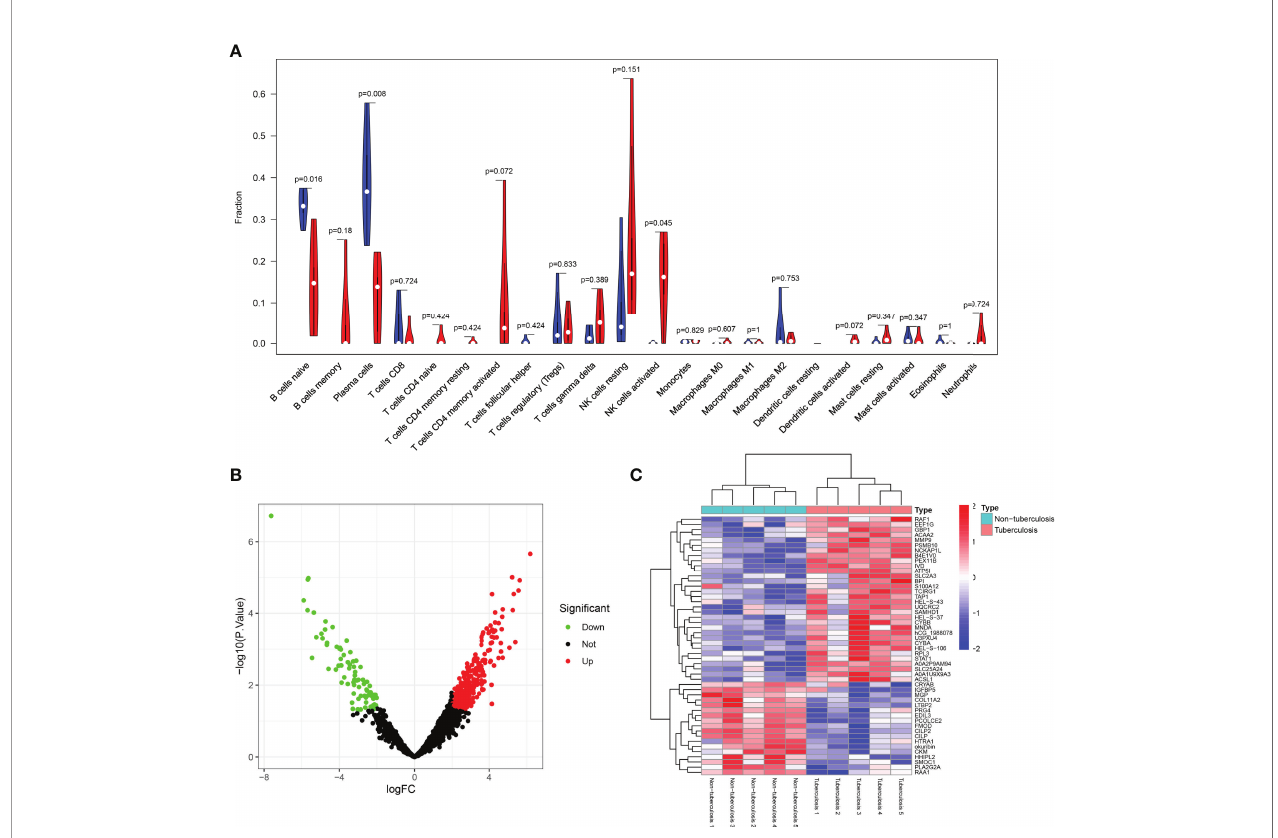
FIGURE 6 | Violin, volcano, and heatmap were plotted. (A) The comparison of 22 immune cell scores in spinal tuberculosis and non-spinal tuberculosis was plotted by the violin plot. There were statistical differences among the three types of immune cells, including B cells naive, platelet cells, and NK cells activated. (B) The volcano plot showed that the differential proteins were divided into up-regulated and down-regulated proteins. (C) The heatmap clearly showed the clustering of the top 50 proteins in spinal tuberculosis tissues and non-spinal tuberculosis